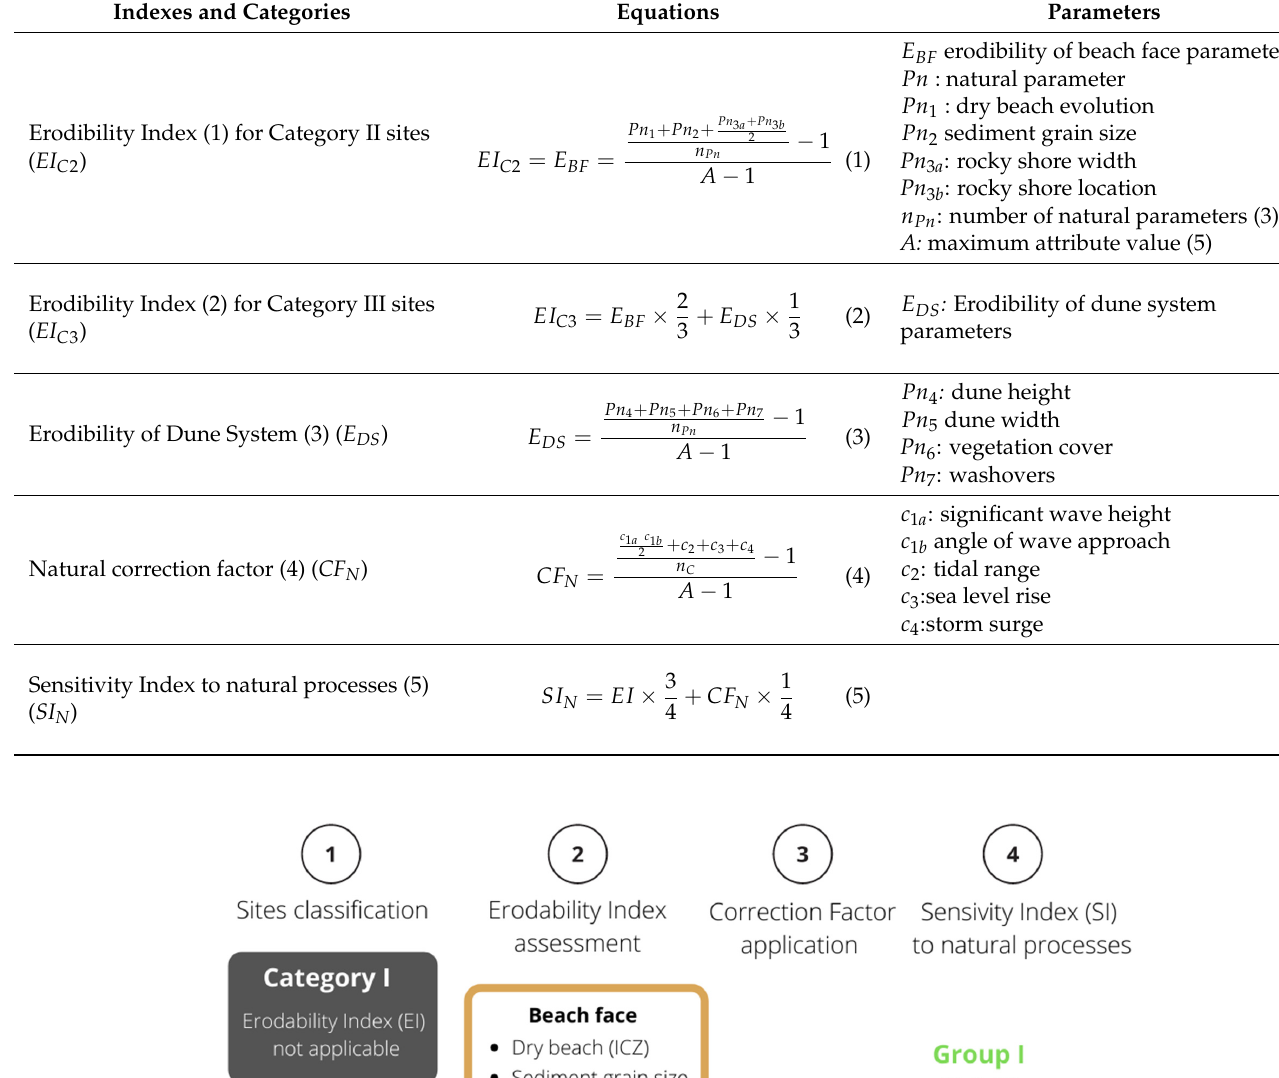
Table 2. Equations regarding Erodibility Index (related to sites categories), Correction Factor and Sensitivity Index.